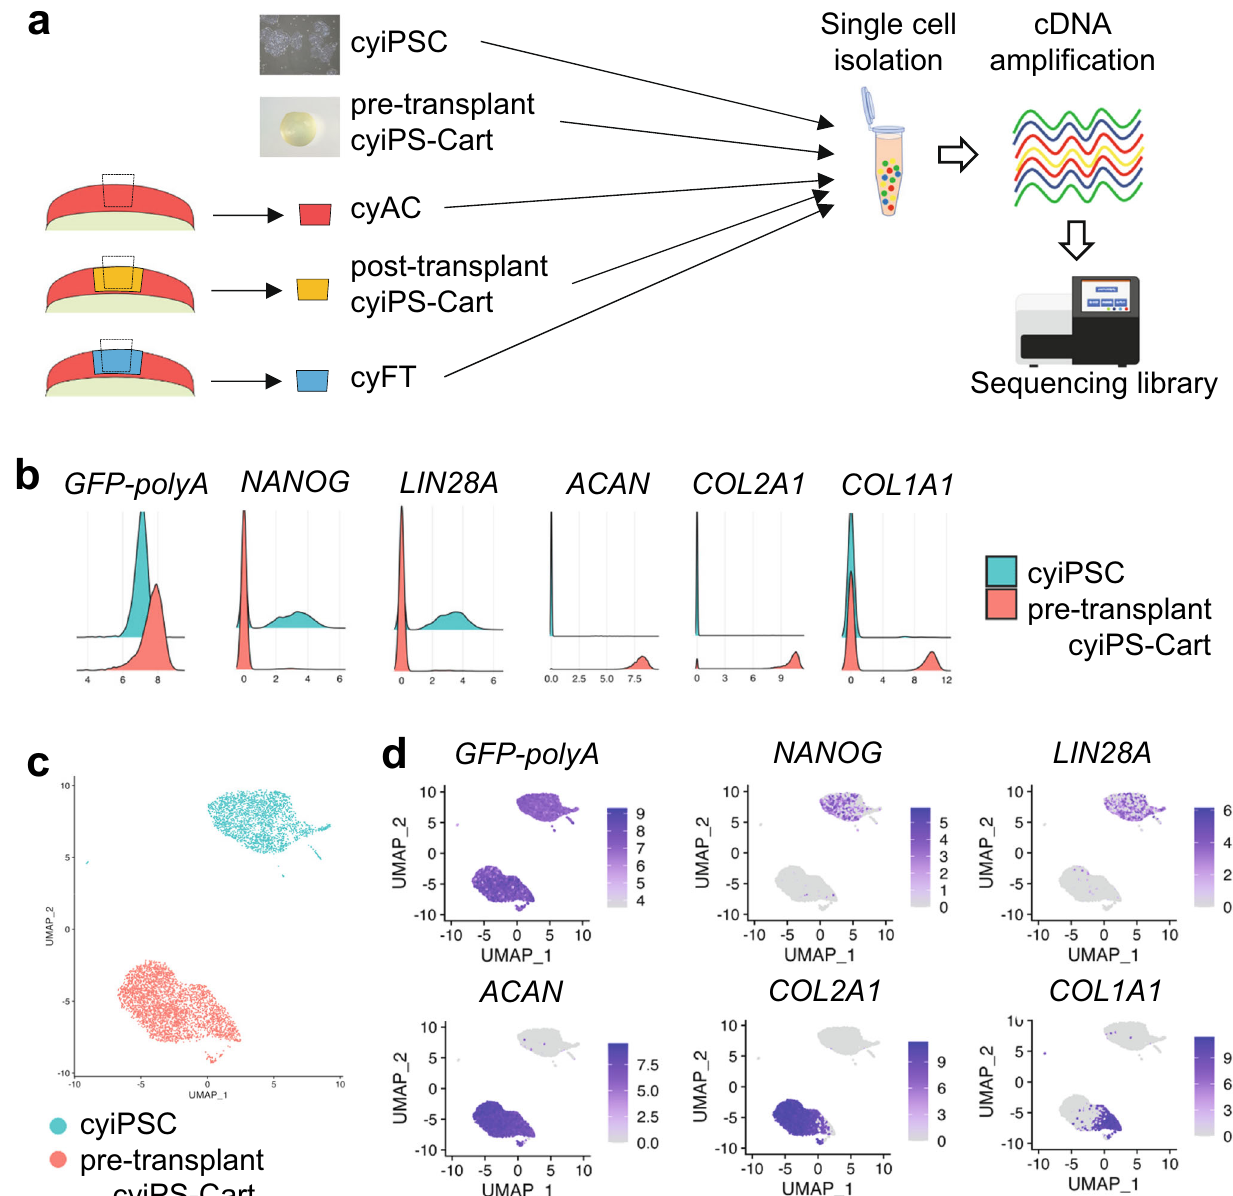
Fig. 5 | scRNA-seq analysis and chondrogenic differentiation of cyiPSCs into pre-transplant cyiPS-Cart. a Schematic representation of samples subjected to scRNA-seq analysis. Undifferentiated cyiPSCs (cyiPSC), cyiPS-Cart (pre-transplant cyiPS-Cart), intact articular cartilage (cyAC), fi brous tissue formed in chondral defects in the empty group (cyFT), and cyiPS-Cart in chondral defects in the transplantation group (post-transplant cyiPS-Cart) 17 weeks after surgery.